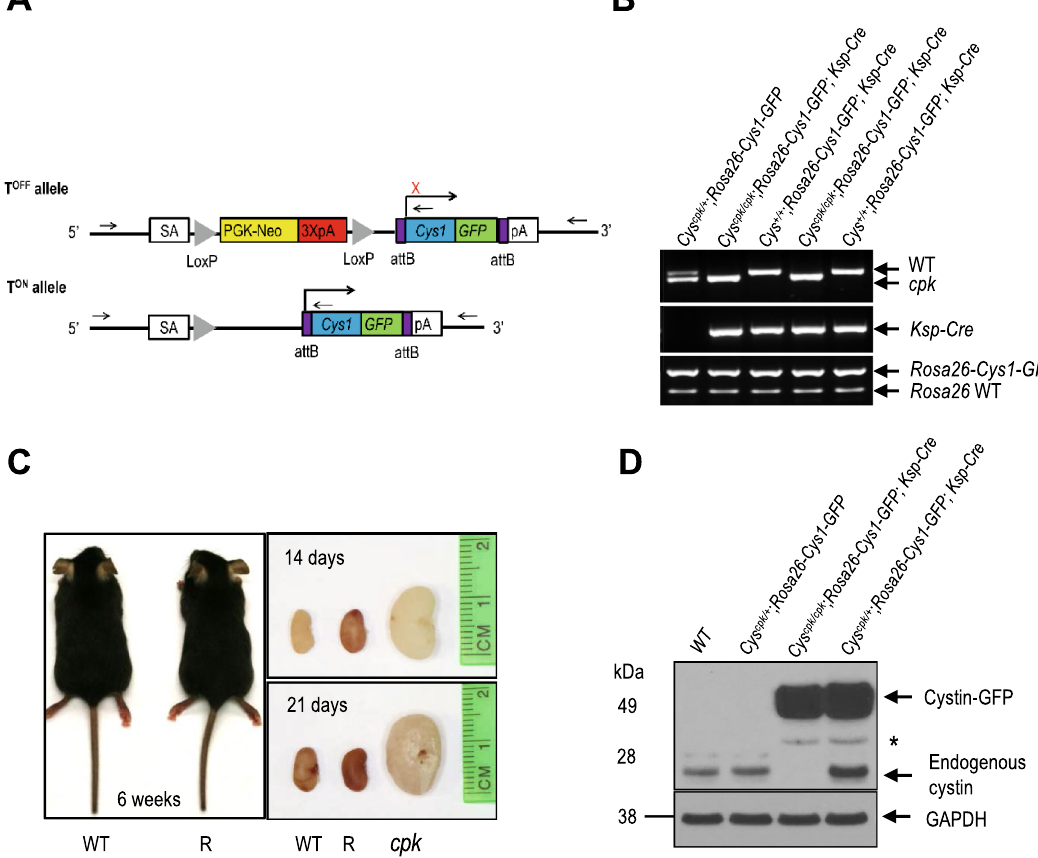
Figure 1. Rescue of cpk mouse phenotype by kidney-specific expression of Cys1-GFP. ( A ) Schematic diagram showing the Cys1-GFP transgene knock-in at the Rosa26 locus ( Rosa26-Cys1-GFP allele) before (T OFF ) and after (T ON ) deletion of a PGK Neo cassette (yellow rectangle) flanked by LoxP sites (gray triangles). In the T OFF configuration, expression of Cys1-GFP is prevented by the PGK Neo cassette. In cells expressing a Ksp- Cre transgene, Cre-mediated recombination deletes PGK Neo and Cys1-GFP is expressed (T ON ). SA: splice acceptor, PGK-Neo: Phosphoglycerate kinase promoter driving a neomycin resistance gene followed by 3 polyA signals (3XpA, red rectangle). The purple boxes flanking Cys1-GFP are attB sites. ( B ) PCR-based genotyping of Rosa26-Cys1-GFP , Ksp-Cre and Cys1 alleles in mice of the indicated genotypes. ( C ) Cys1-GFP rescue of gross phenotypes in cpk mice. Six-week-old wild-type (WT) and Cys1 cpk/cpk ; Rosa26-Cys1-GFP; Ksp-Cre/ + rescued (R) mice are of equivalent size. Examination of kidneys from WT, R and cpk mice at 14 and 21 days of age show equivalent sizes of R and WT kidneys, with both markedly smaller than cpk kidneys. ( D ) Western blot analysis of total kidney protein from 6-week-old mice of the indicated genotypes. Mouse cystin is 145 amino acids long but migrates aberrantly at ~ 25 kDa on SDS-PAGE. Cystin-GFP (arrow, ~ 50 kDa) and endogenous cystin (arrowhead, ~ 25 kDa) were detected using polyclonal rabbit anti-cystin antibody, as previously described 19 . GAPDH served as an internal protein loading and transfer control. The asterisk indicates non-specific